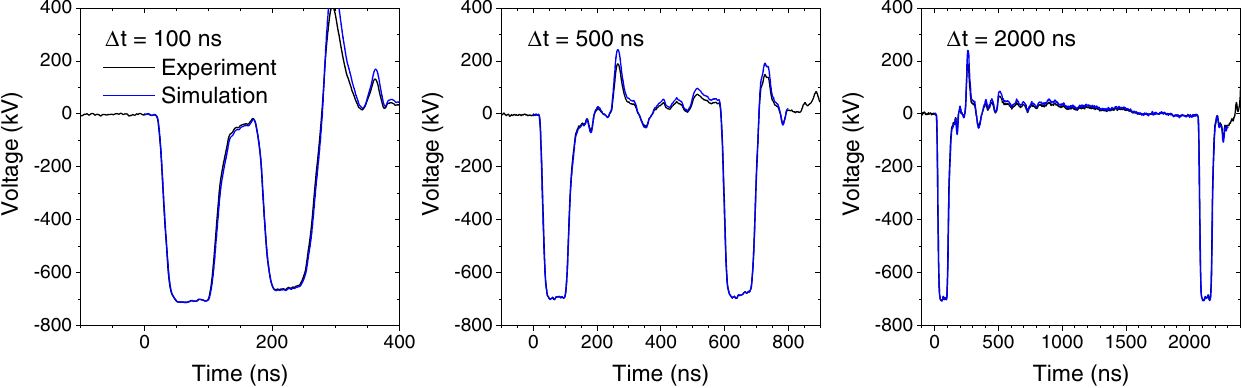
FIG. 6. Comparison of simulated (blue curve) and experimental voltages (black curve) for Δ t ranging from 100 to 2000 ns.